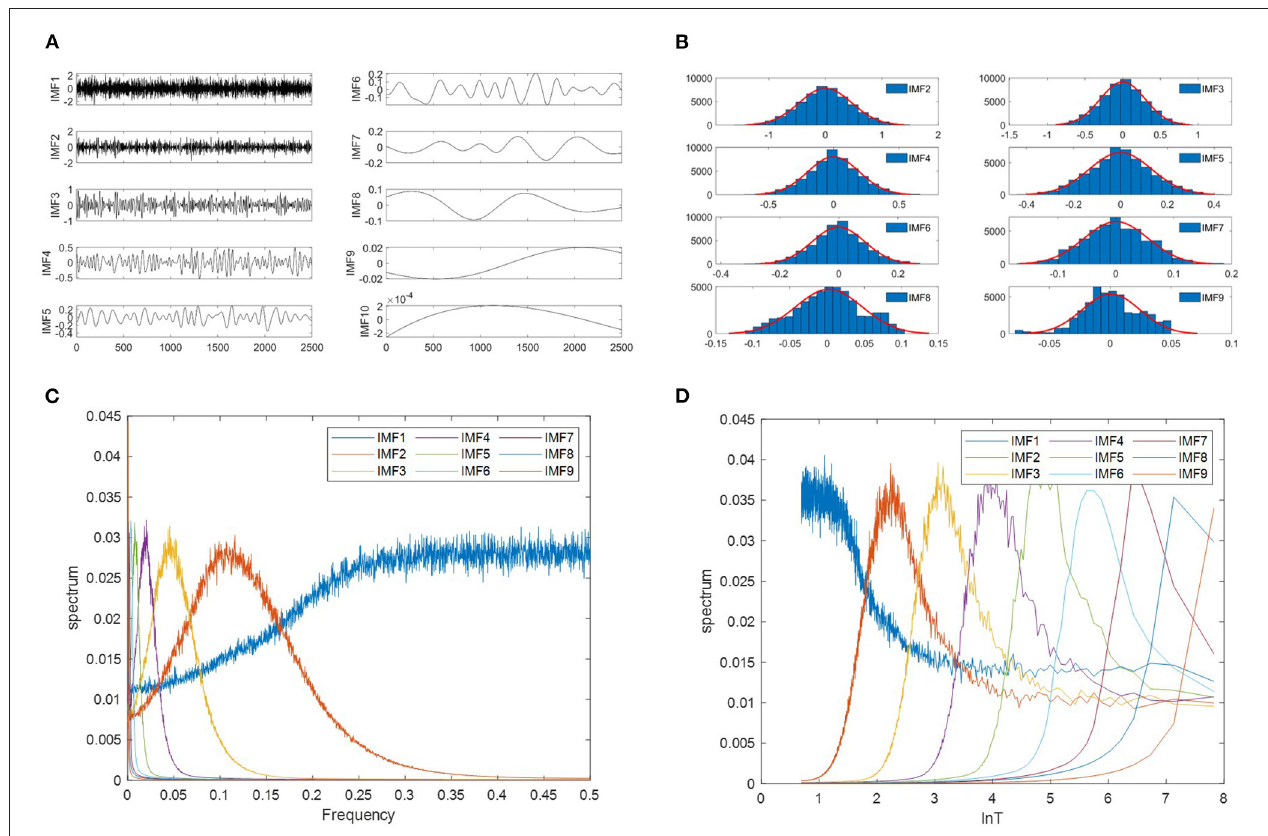
FIGURE 2 | Properties of IMFs derived from white noise using EMD. (A) The waveforms of the first 10 IMFs decomposed from a white noise signal. The length of the white noise is 2,500 points. (B) The probability distribution function(PDF) of IMF follows a normal distribution. (C) EMD equivalent filters. 1,000 independent white noises of 2,500 points each have been generated, and average spectra of the nine IMFs are plotted as a function of normalized frequency. (D) The Fourier spectra of IMFs as a function of the logarithm of the period. The samples are the same with (C)